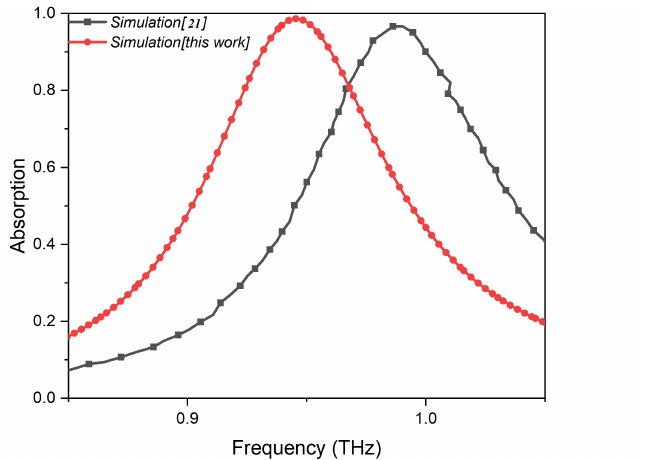
Figure 3. Comparison between the absorptions of the metamaterial absorber reported in [21] and our